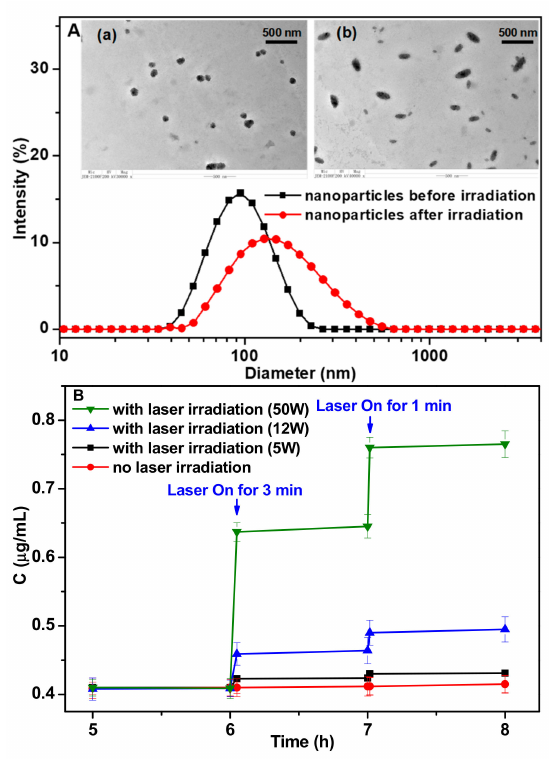
Figure3. ( A )DLSresultsandTEMimages( a , beforeirradiation; b , afterirradiation)oftheself-assembled MTX-AMC-PEG nanoparticles; ( B ) The photo-responsive release profiles of MTX from the nanoparticles (1 mg / mL) exposed to laser irradiation (365 nm, 5.0 W, 12 W, 50 W) for 1 min and 3 min in PBS (pH 7.4). Means + SD (n =